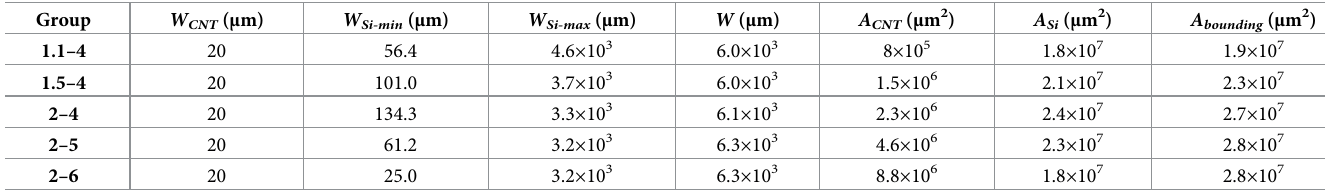
Table 2. Geometric measurements for the fractal electrodes.